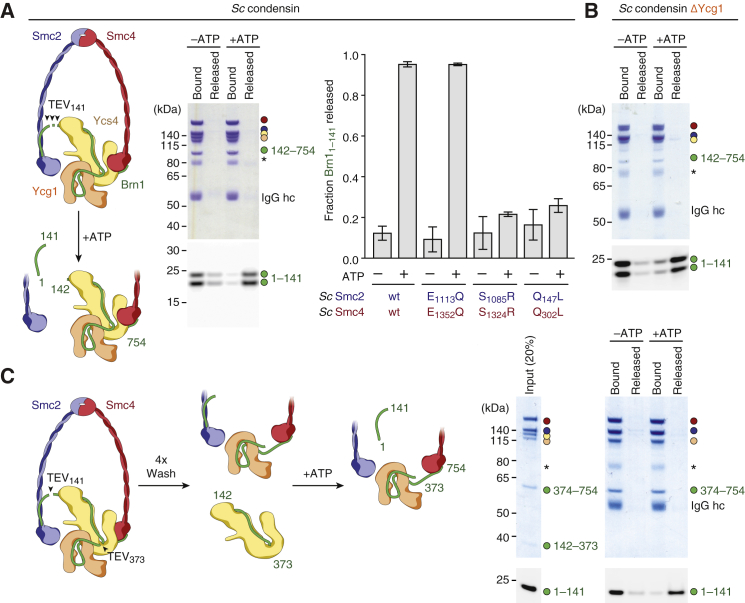
ATP-Binding-Dependent Release of the Smc2cc-Brn1N Interaction(A) Sc condensin holocomplexes containing a Brn1 subunit labeled via an N-terminal ybbR tag with the fluorescent dye ATTO488 and a triple TEV protease cleavage site at position 141 were incubated with TEV protease before immunoprecipitation. Shown is Coomassie staining (top) and an in-gel fluorescence scan (bottom) of SDS-PAGE of bound or released fractions after washing immunoprecipitation beads with buffer without nucleotide (–ATP) or containing 1 mM ATP (+ATP). The graph shows fluorescence intensities of the Brn11–141 fragment in the released fractions of WT (purified from strain C5066), Walker B (Smc2E1113Q, Smc4E1352Q; C5142), signature motif (Smc2S1085R, Smc4S1324R; C5139), or Q-loop (Smc2Q147L, Smc4Q302L; C5125) mutant condensin complexes (mean ± SD from 3 independent experiments).(B) As in (A), using purified condensin complexes that lack the Ycg1 subunit (C5110).(C) Brn1 of condensin holocomplexes (C5122) was cleaved simultaneously at positions 141 and 373. Extensive washing steps during immunoprecipitation removed Ycs4-Brn1142–373. Immunoprecipitated condensin complexes were then washed with buffer without nucleotide (–ATP) or containing 1 mM ATP (+ATP) as in (A).See also Figure S7.